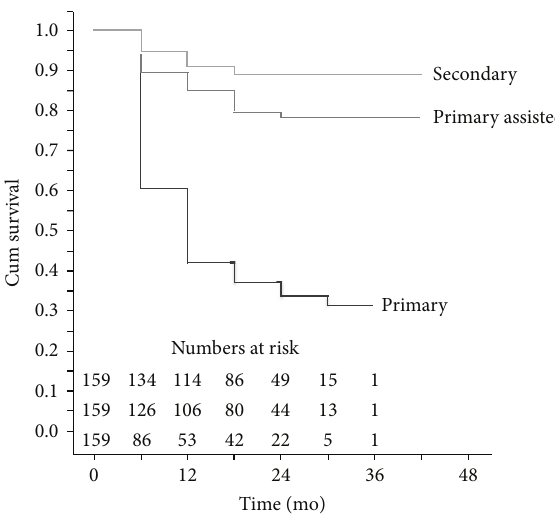
Figure 5: Patency (percentage) without subsequent reintervention after 1st, 2nd, and 3rd PTA, respectively. Black columns represent patency at 6 months and grey columns at 12 months. There is no statistically significant difference in the patency of the 1st, 2nd, and 3rd PTA.